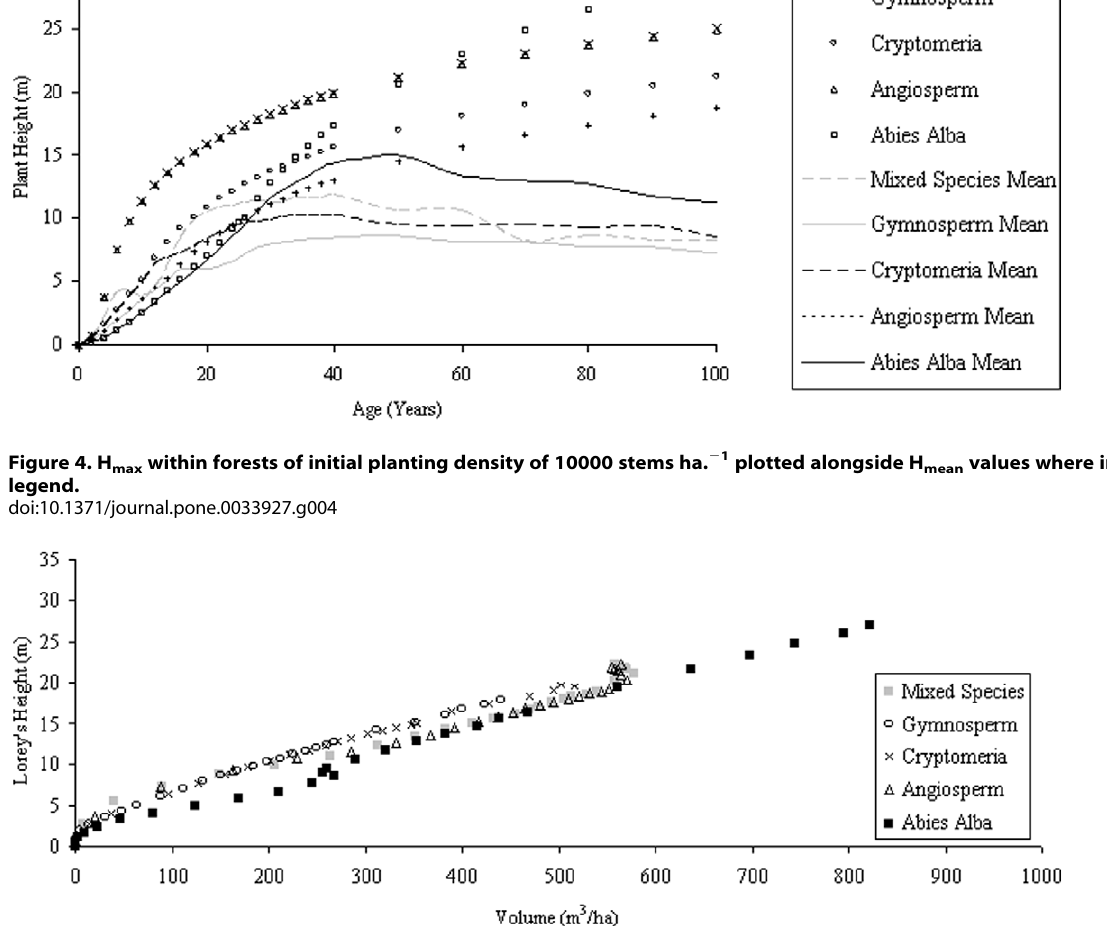
Figure 5. H Lorey against forest volume for planting densities of 10,000 ha. 2 1 .